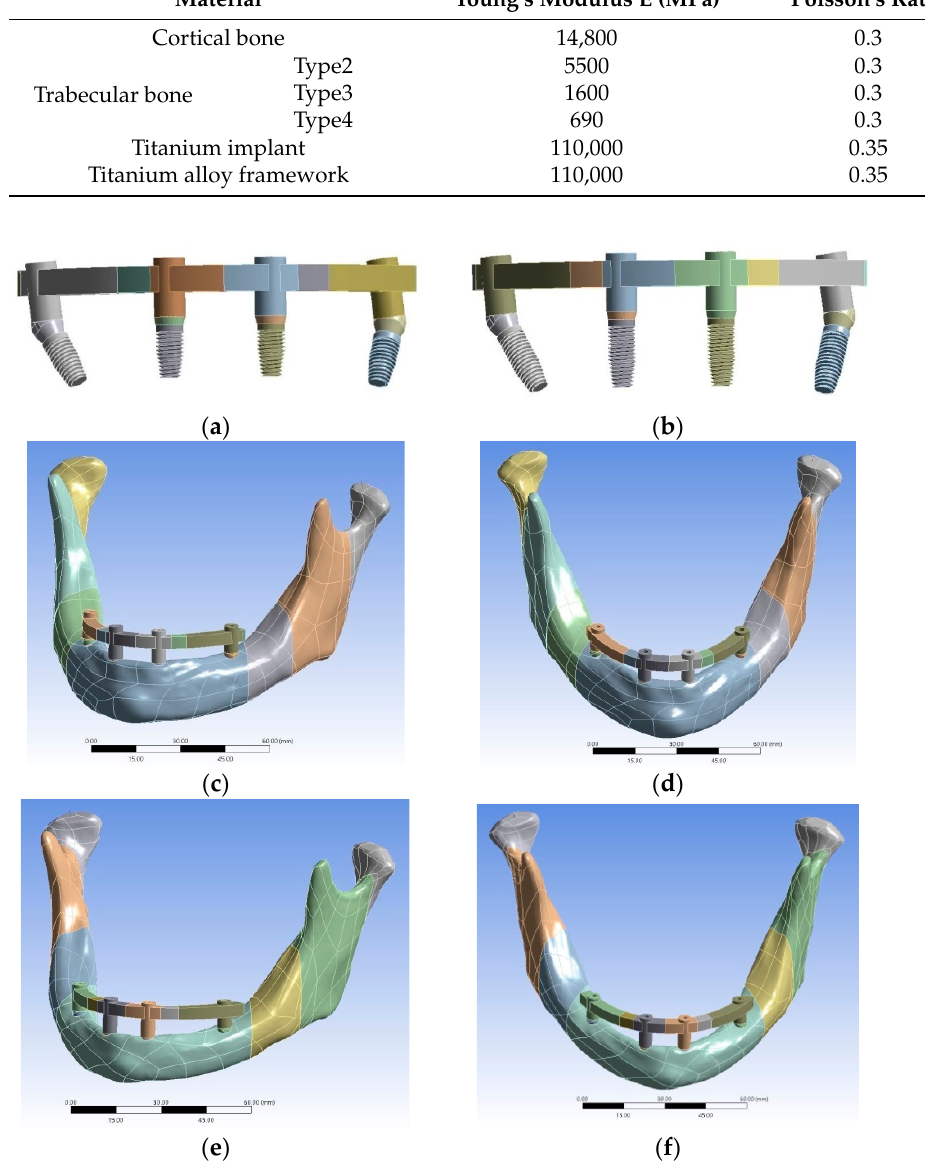
Figure 1. ( a ) 9mm implant length; ( b ) 11.5mm implant length; ( c , d ) mild atrophy trabecular bone; Figure 1. ( a ) 9 mm implant length; ( b ) 11.5 mm implant length; ( c , d ) mild atrophy trabecular bone; ( e , f ) moderate atrophy trabecular bone. ( e , f ) moderate atrophy trabecular